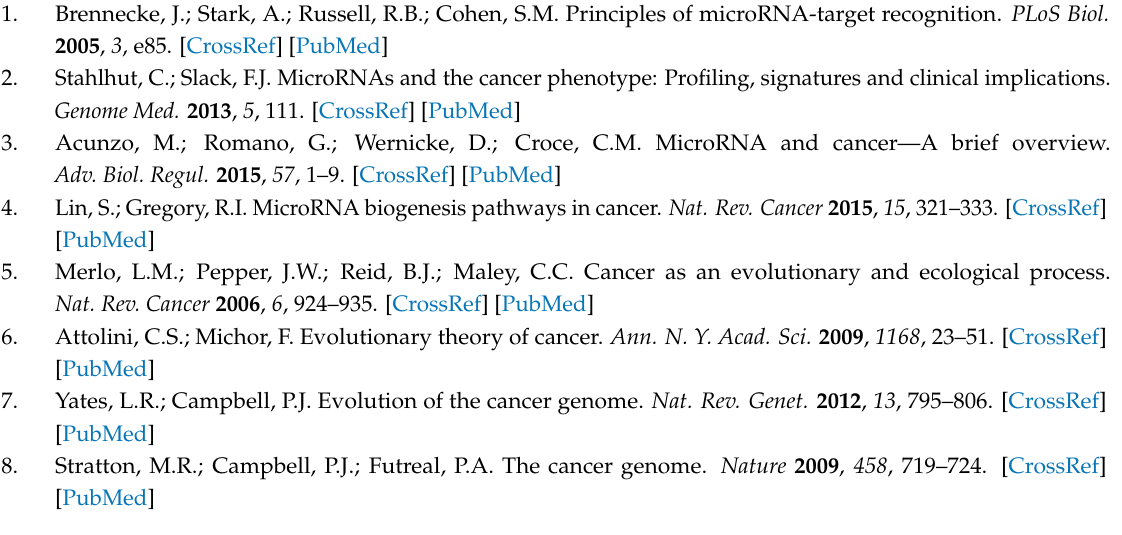
Figure S1: The distribution of absolute affinity, Figure S2: The density of depth in 3 (cid:48) UTR, Figure S3: Eighteen modules of miRNAs in gain status, Table S1: FuncMutations, Table S2: FuncMutations in experimentally validated miRNA-mRNA interactions, Table S3: The relationship between tarGenes and cancer